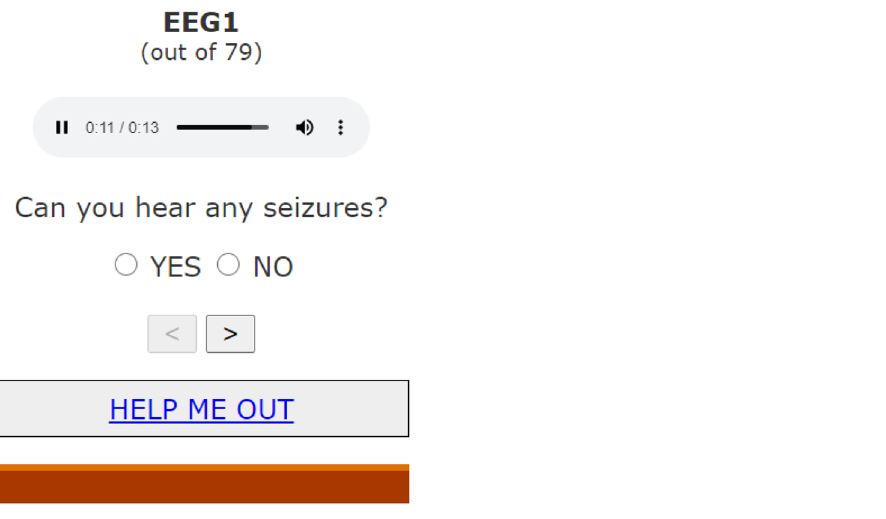
Figure 3. Snapshot of web survey to assess the AI-driven sonification